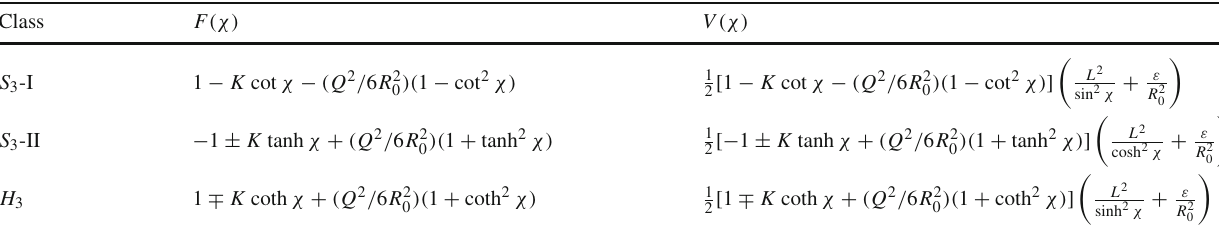
Table 2 Effective potential V